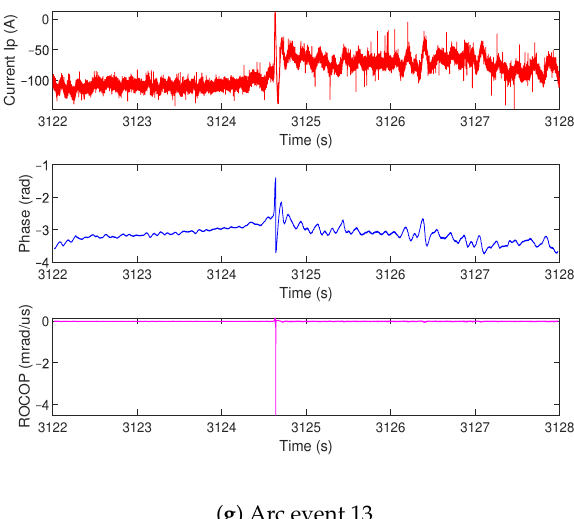
Figure 5. Instantaneous recorded I p , instantaneous calculated phase angle, and instantaneous ROCOP for all of the arcs detected during the regenerative braking phase.